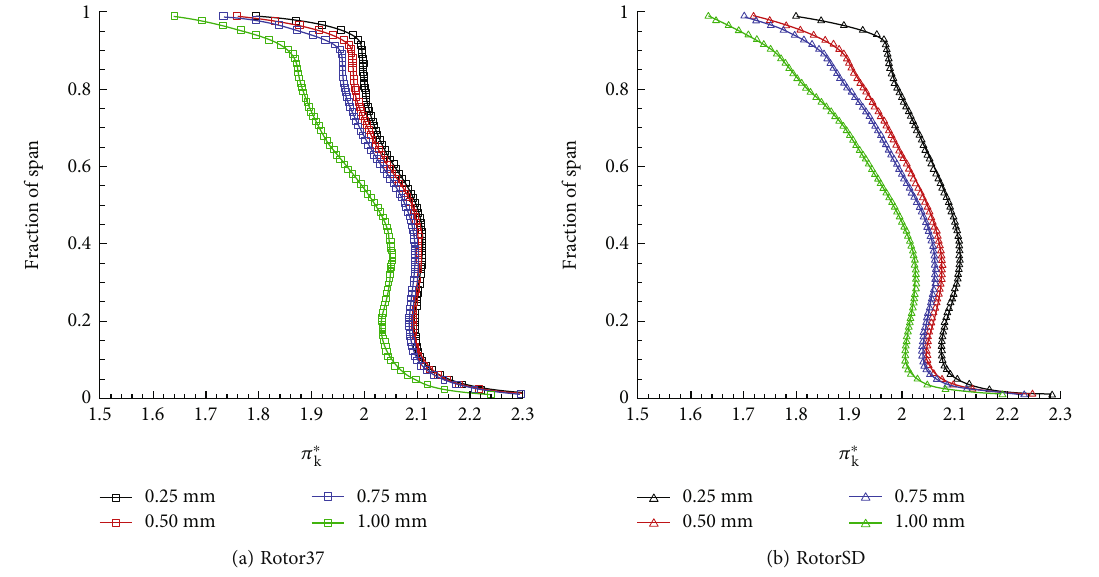
Figure 11: Total pressure ratio distribution along the